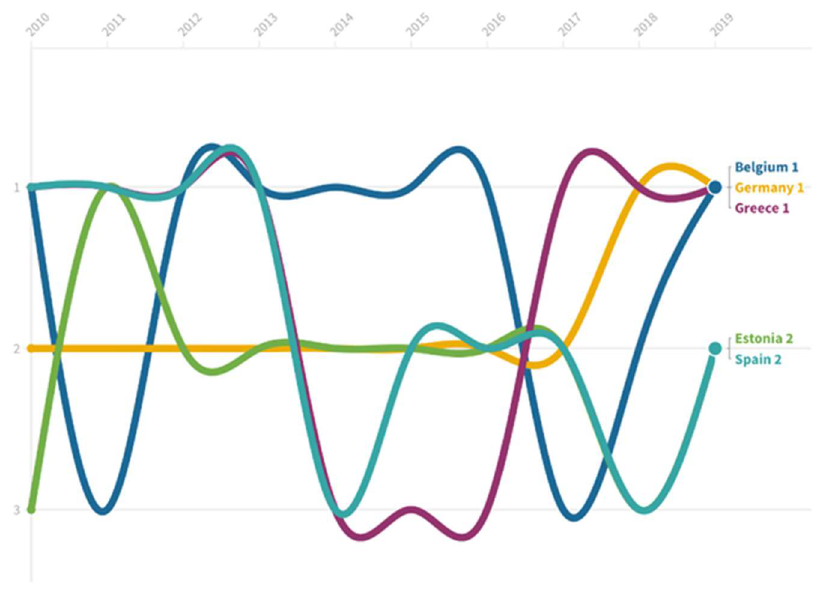
Figure A2. Detailed timelines for the three-cluster case. Source Authors’ construction.